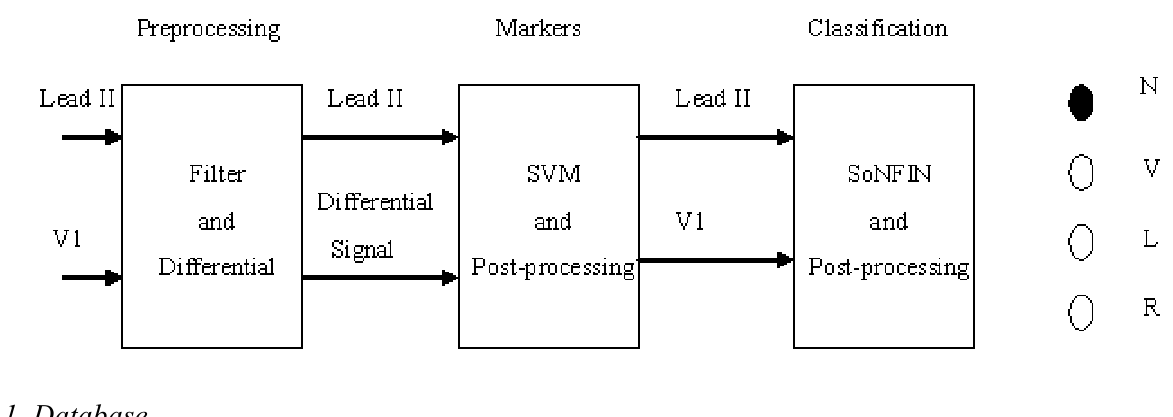
Figure 1. Stages of an automatic classifying